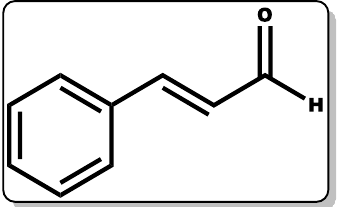
Figure 12. Molecular structure of cinnamaldehyde.